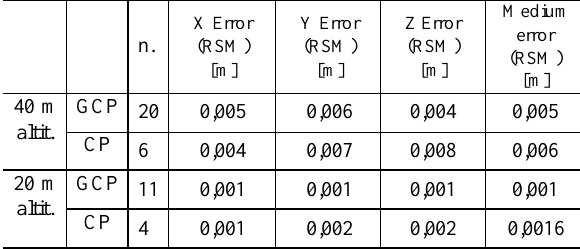
Table2. Very similar accuracy results for the different altitude